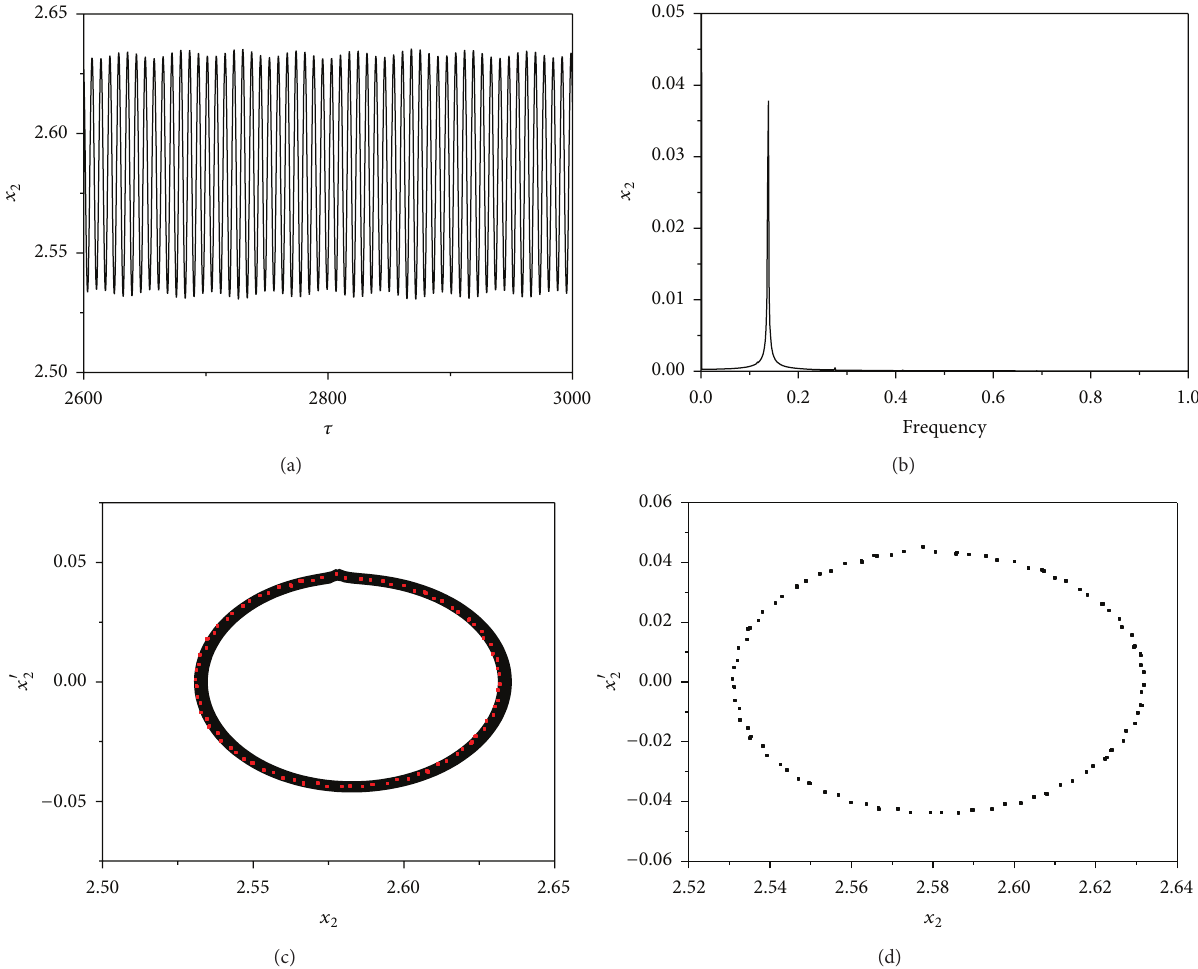
Figure 12: See 𝜔 = 0.70 . (a) Displacement response. (b) Frequency spectrum. (c) Phase-portrait plots. (d) Poincar´e